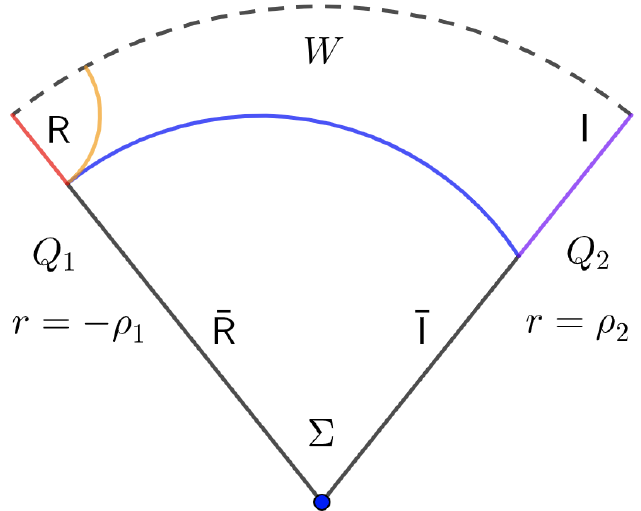
Figure 7 . Geometry for case I: one black hole approximately. Q 1 denotes the bath brane with weak gravity, and Q 2 is the AdS brane with intense gravity. The red and black lines denotes the radiation R and its complement ¯ R on the left brane, the purple and black lines denotes the island I and its complement ¯ I on the right brane. The island region I and radiation region R envelop the black-hole horizon on Q 1 ∪ Q 2 . For simplicity, we only show the regions outside the horizon. The dotted line, blue, and orange lines in the bulk indicate the horizon, RT surface in the island phase and HM surface in the no-island phase at t = 0 , respectively.